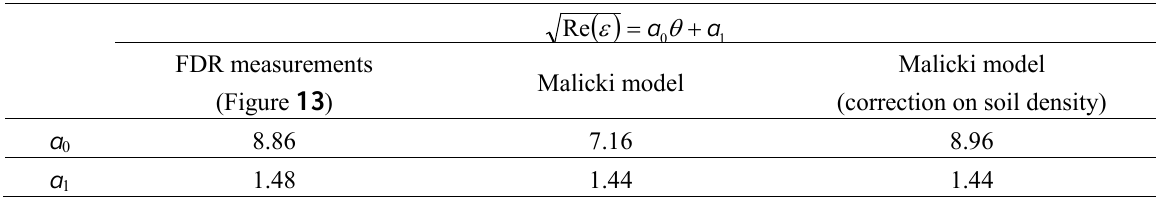
  Re aa   10 Malicki Malicki model